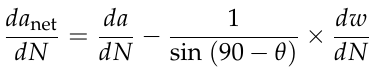
Figure 4. Location of Total DI for both left and right rails.